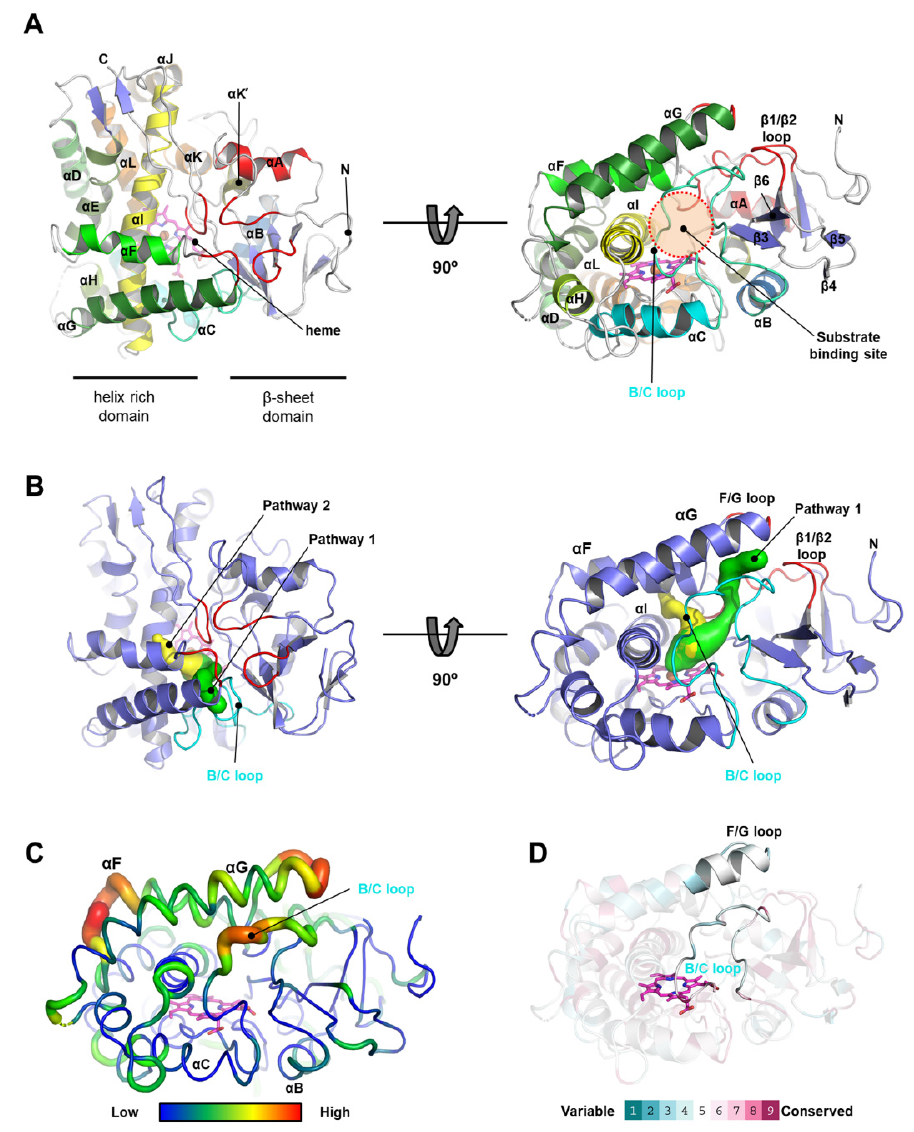
Figure 4. Overall structure and structural features of CYP101D5. ( A ) The overall structure of CYP101D5 is presented by a ribbon diagram with a top view (left) and a 90° rotated view (right). Loops close to the substrate recognition site and the B/C loop of CYPs are marked with red and cyan. The bound heme molecule is represented by a stick model in magenta. ( B ) The predicted substrate pathways for CYP101D5 were calculated by the program CAVER [42] and are presented in green and yellow. ( C ) B-factor distribution of CYP101D5 shown in a putty representation. Residues with a higher B-factor are presented in red. ( D ) Sequence variation of CYPs. The residues in a cartoon structure are colored according to their conservation grades using the nine-grade color-coding bar. The F/G and B/C loops are highlighted with no transparent presentation.